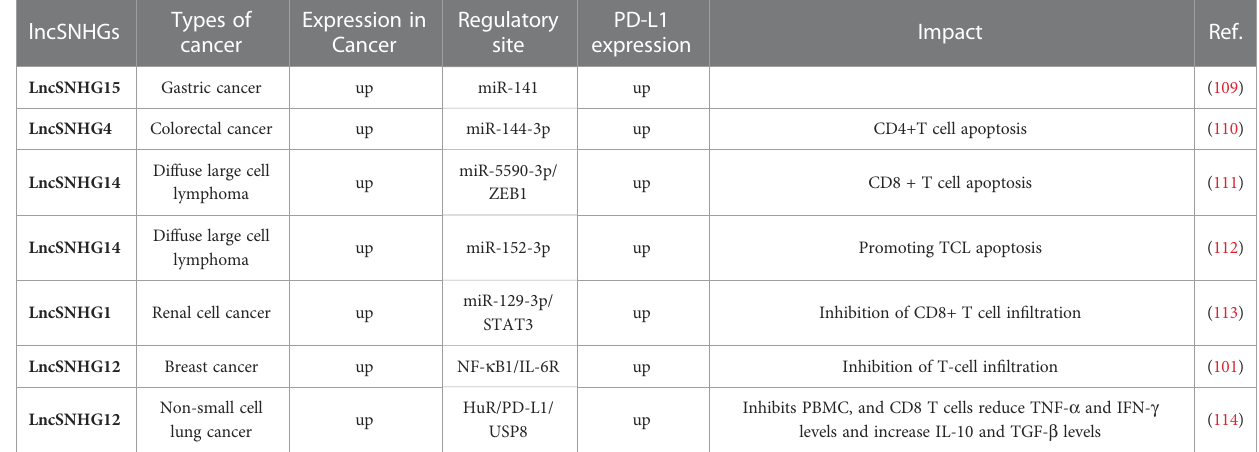
TABLE 2 Effect of different lncSNHGs on